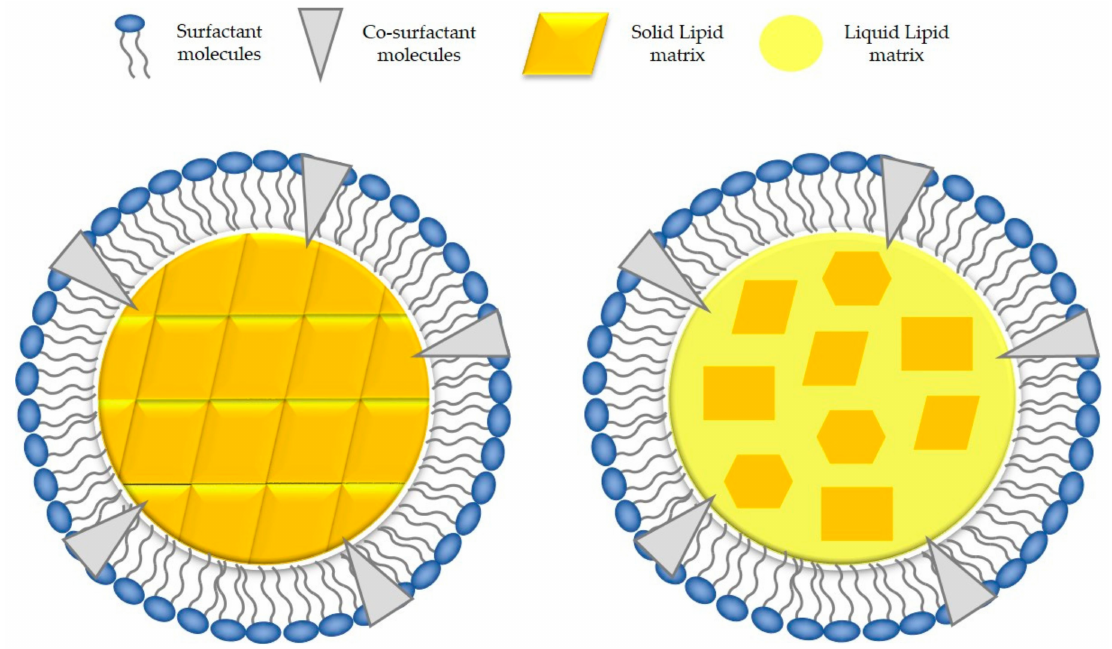
Figure 3. Schematic representation of lipid core structure of SLNs ( left ) and NLCs ( right ). Geometrical forms in the NLCs scheme represent different solid lipid